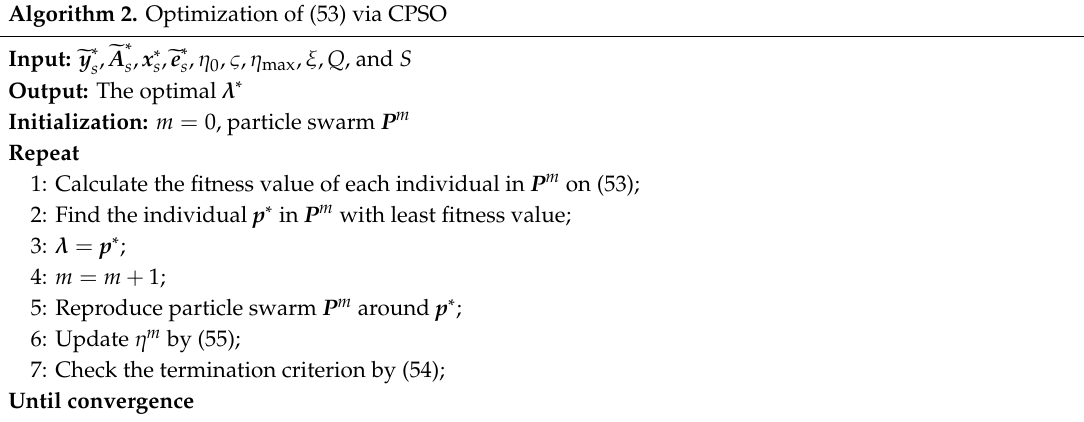
Algorithm 2. Optimization of (53) via